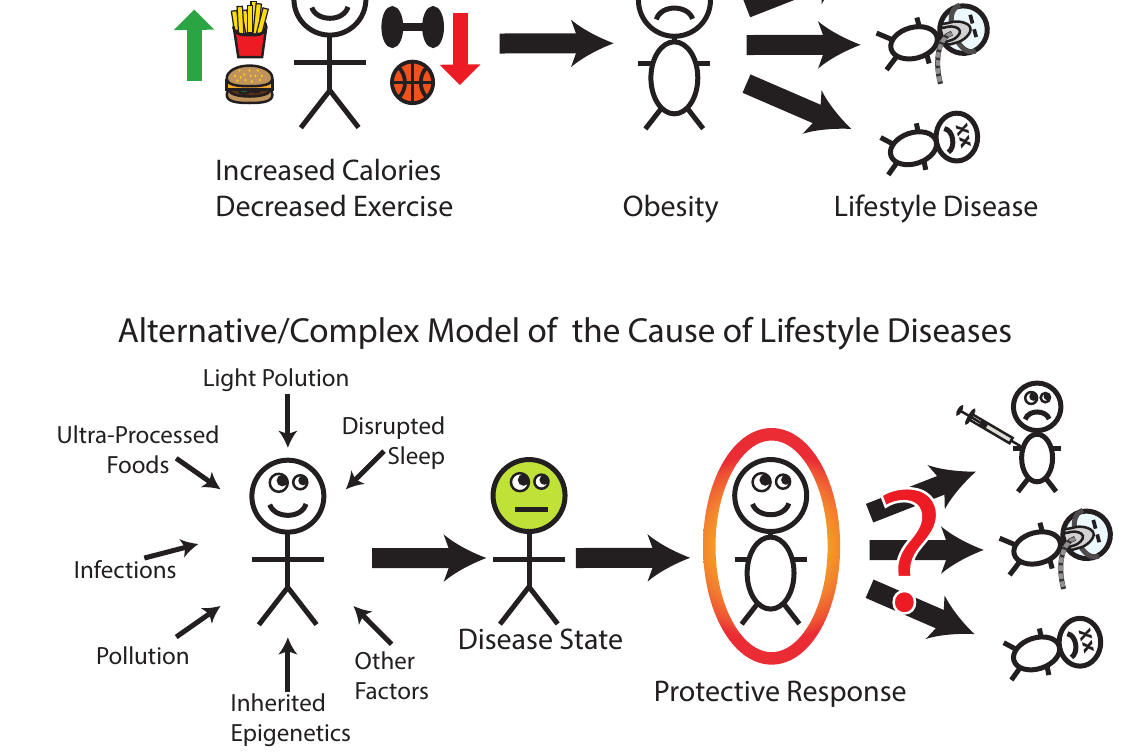
Figure 1. Models of the cause of lifestyle diseases: ( A ) a traditional model posits obesity as the lynchpin of lifestyle disease. If lifestyle diseases (diabetes, obstructive sleep apnea, etc.) are caused by obesity, and obesity is caused by eating too much and not exercising enough, the cure is simple